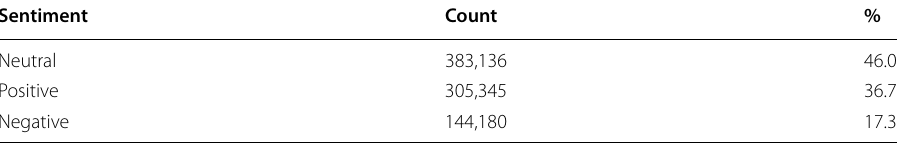
Table 3 Diagram showing the frequency distribution of sentimental analysis using TextBlob